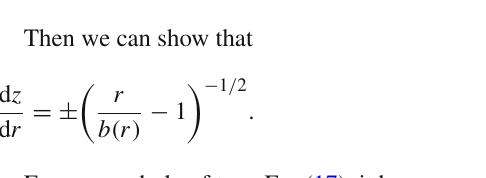
space whose metric can be written in the form d s 2 = d z 2 + d r 2 + r 2 d φ 2